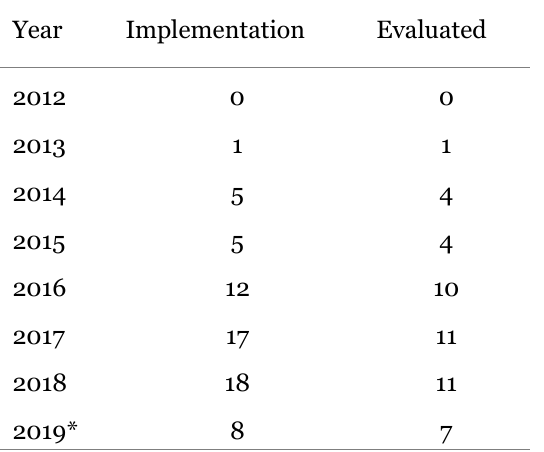
Number of Publications on Implemented and Evaluated Recommender